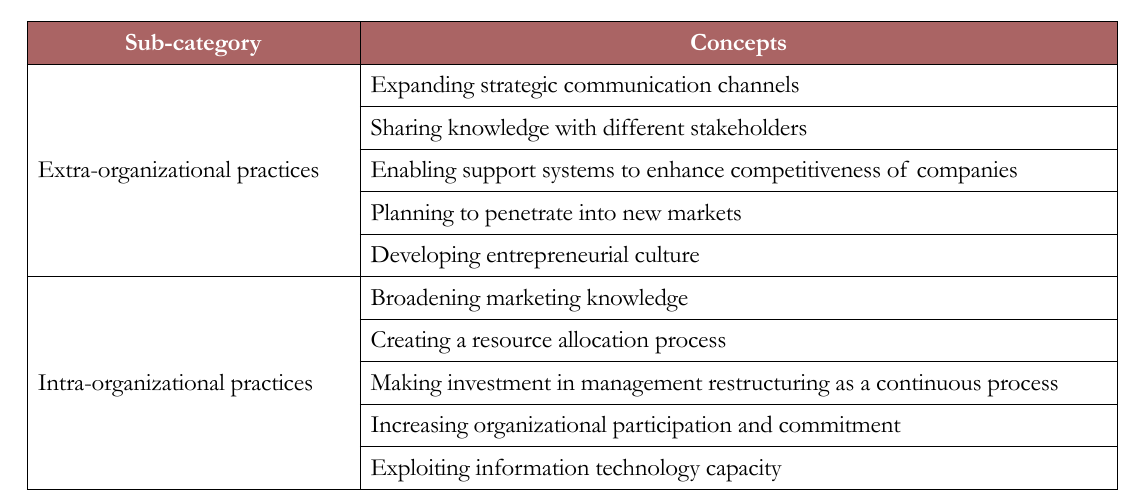
Table 7. Concepts and sub-categories of strategies